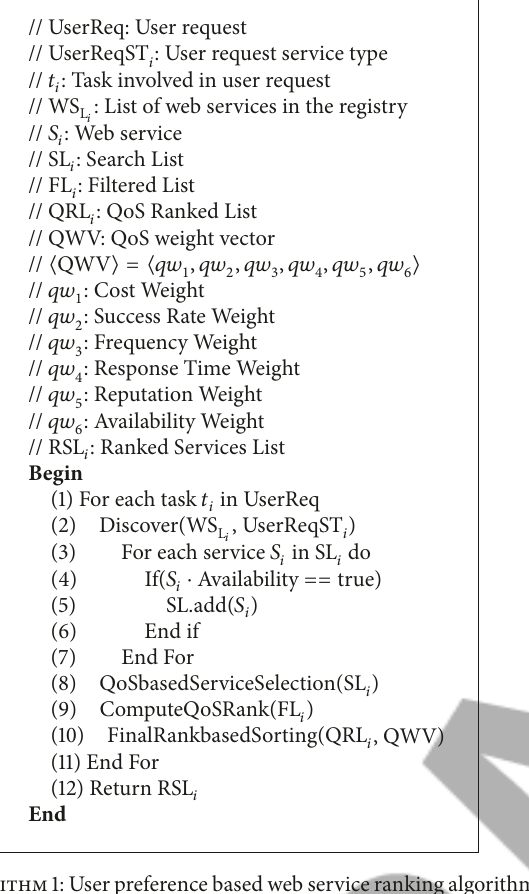
Algorithm 1: User preference based web service ranking algorithm (UR( 𝑇 , QWV, 𝐶 ), WS L 𝑖